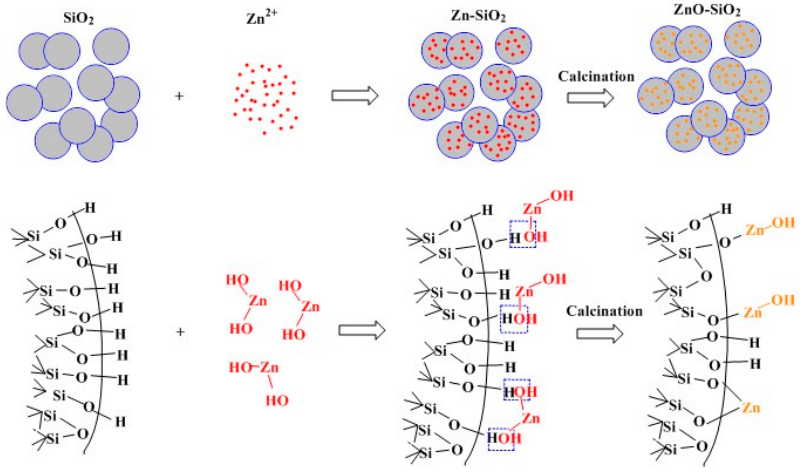
Figure 8. Synthesis of the ZnO–nSiO 2 Complex